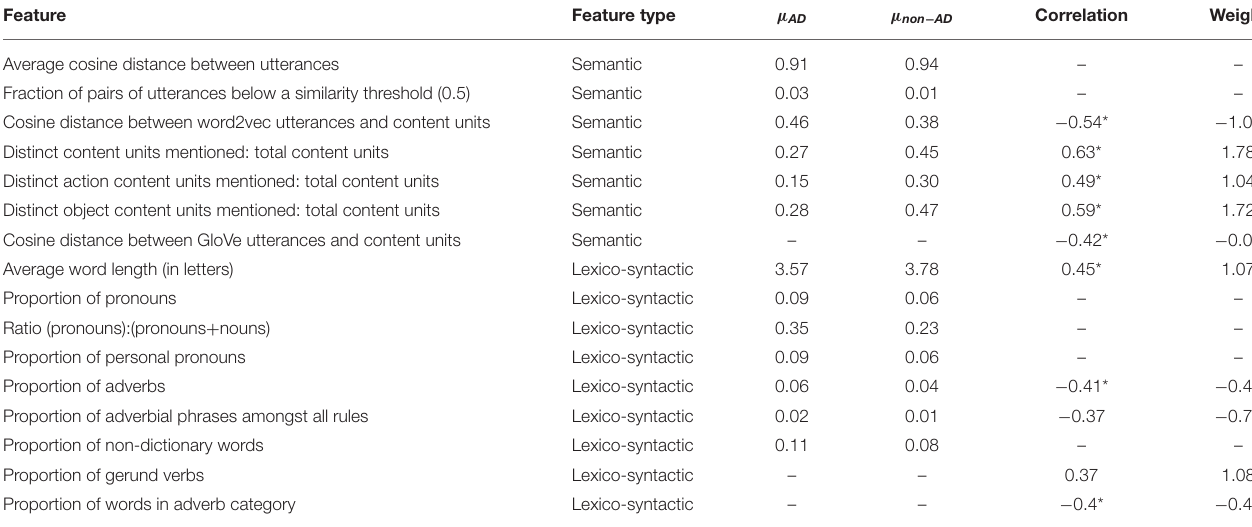
TABLE 10 | Feature differentiation analysis results for the most important features, based on ADReSS train set. Feature